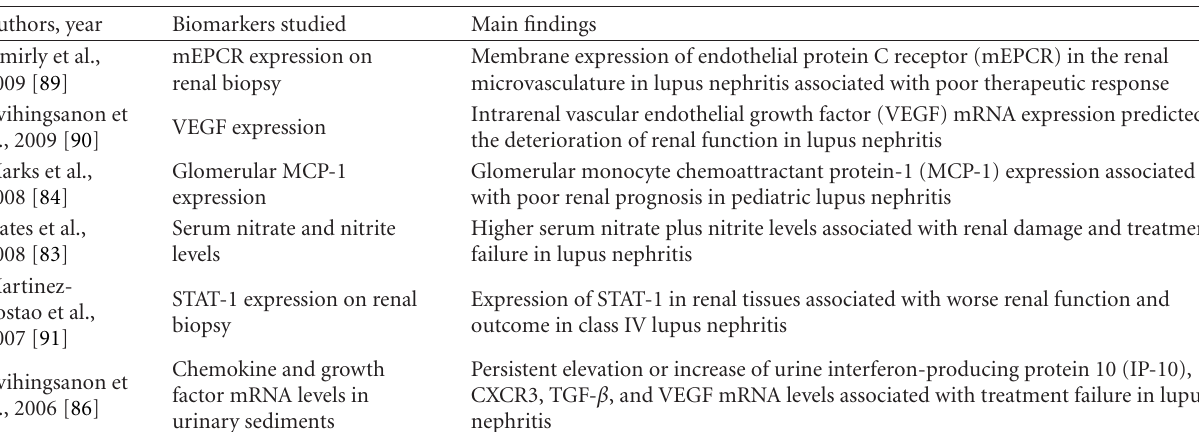
Table 4: Biomarkers that correlate with prognosis in lupus